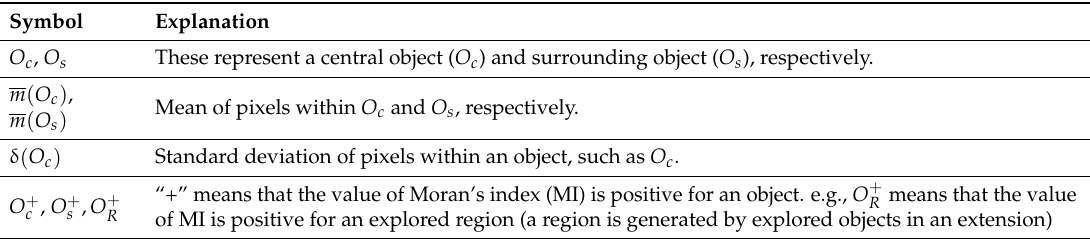
Table 1. Explanation of symbols in the rule and its related algorithm.